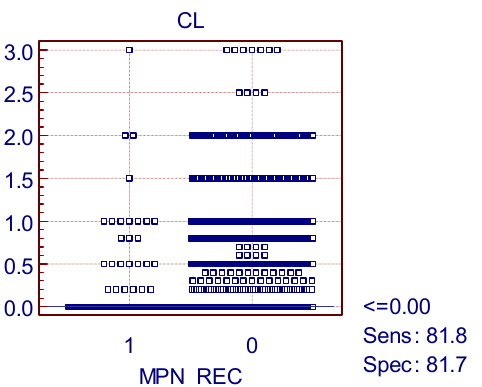
Fig. 2. Specific range of free residual chlorine to determine optimal cutoff point in prevention of total and fecal coliform